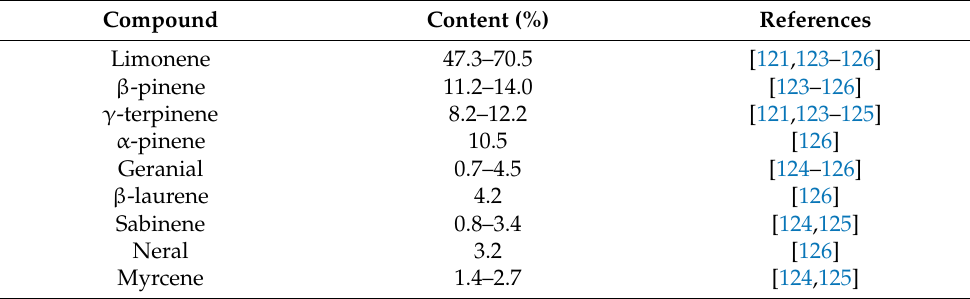
Table 7. Prevailing components of C. limon essential